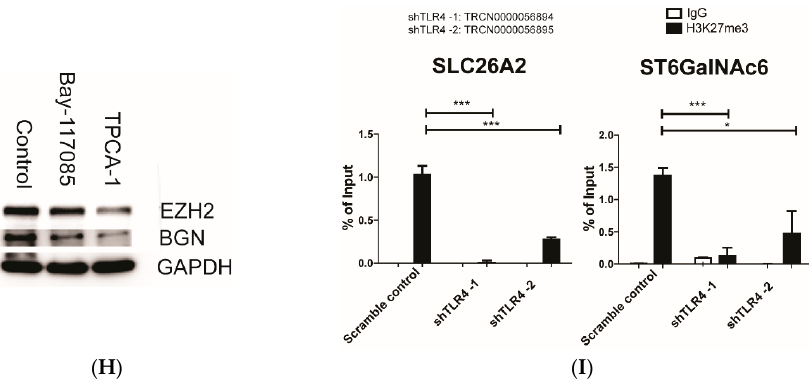
Figure 4. TLR4 modulates BGN activity through NF- κ B. ( A , B ) Promoter analysis of NF- κ B (pGL4.31) and BGN promoter (-823/-1) after treatment with TLR4 inhibitor (TAK-242) for 1 d. Firefly luciferase activity was normalized to Renilla luciferase activity. ***, p < 0.001;**, p < 0.01 ( n = 3 with mean ± SD shown). ( C ) Western blot experiments of BGN in LS174T after the administration of shRNA for TLR4. ( D ) ChIP/RT-qPCR results of p65 levels in BGN promoter regions in LS174T cells. ( E ) DAPA of the p65-binding site in the BGN ( − 656 to − 627, CAGGCAAGCTGGGGAGCCCCCTGCCCCGTC) promoter. p65 binding to biotinylated oligonucleotides containing either wild-type (p65) or a mutated p65-binding (p65 mut) sequence was assayed by DNA affinity precipitation and analyzed by western blotting using nuclear extracts of HT-29 and LS174T cells. ( F ) Promoter analysis BGN promoter (-823/-1) and BGN p65 deletion promoter after transfection for 1 d. ( G ) BGN mRNA in LS174T cell after administration with Bay11-7085 (10 μ g/ml) or TPCA-1 (5 μ g/ml) for 6 h analyzed by RT-qPCR. ( H ) Western blot experiments of BGN in LS174T after administration with Bay11-7085 (10 μ g/ml) or TPCA-1 (5 μ g/ml) for 3 d. ( I ) ChIP/RT-qPCR results of H3K27me3 level in SLC26A2 and ST6GalNAc6 promoter regions in LS174T cells.